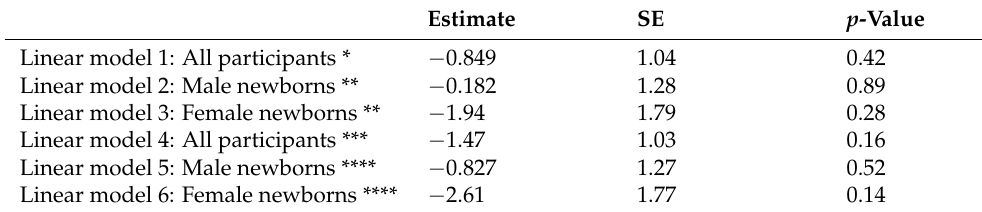
Table 2. Coefficients (estimate), standard error, and p -values from linear regression models for all participants and their newborns.